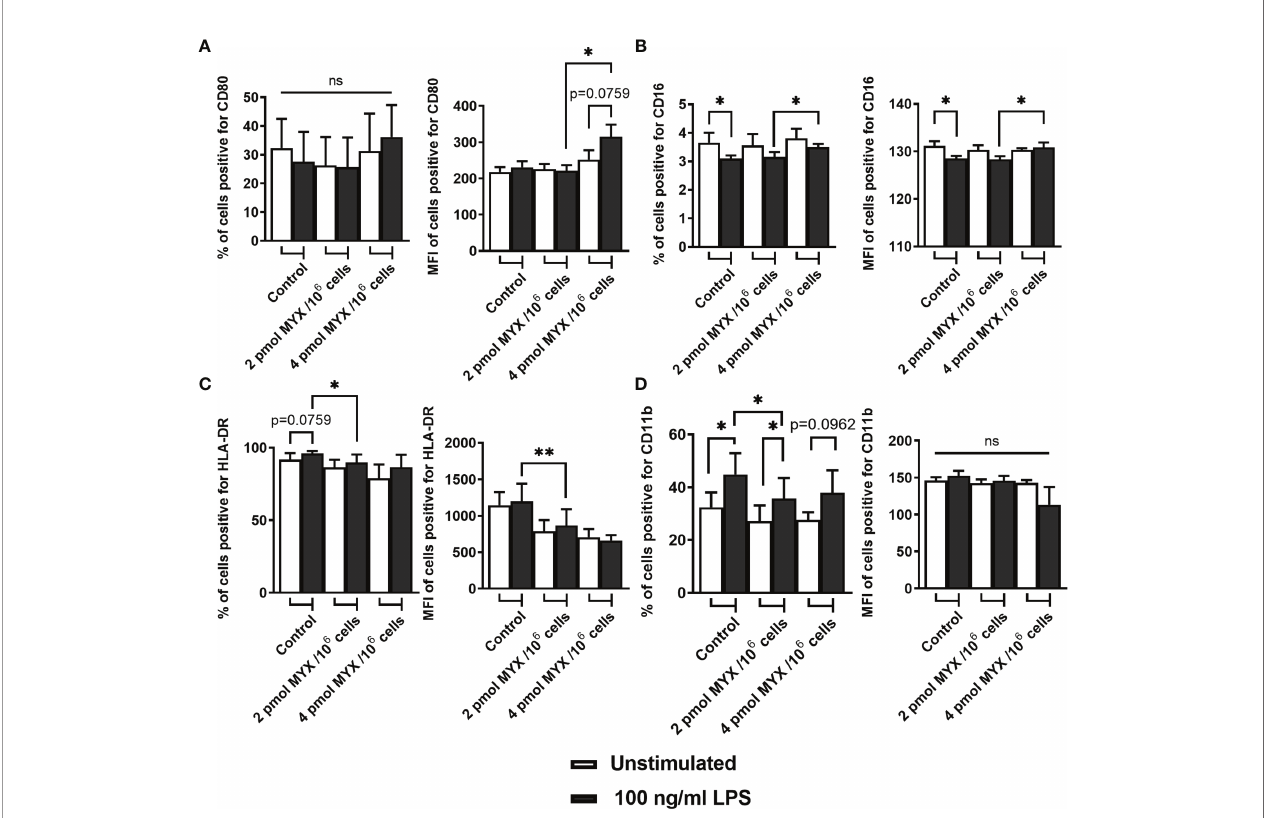
FIGURE 3 | Metabolic restriction with MYX modi fi es expression of surface markers of activation. (A-D) Percentage and median fl uorescence intensity of quiescent and stimulated (100 ng/mL LPS) human monocytes positive for staining of surface (A) CD80, (B) CD16, (C) HLA-DR and (D) CD11b in the presence or absence of MYX (pmol/10 6 cells) or vehicle control (1% (v/v) DMSO) under glucose free conditions. Cells were incubated for 4 hours. (mean ± SEM; n = 6; *p < 0.05; **p < 0.01; Wilcoxon signed rank test). ns, not signi fi